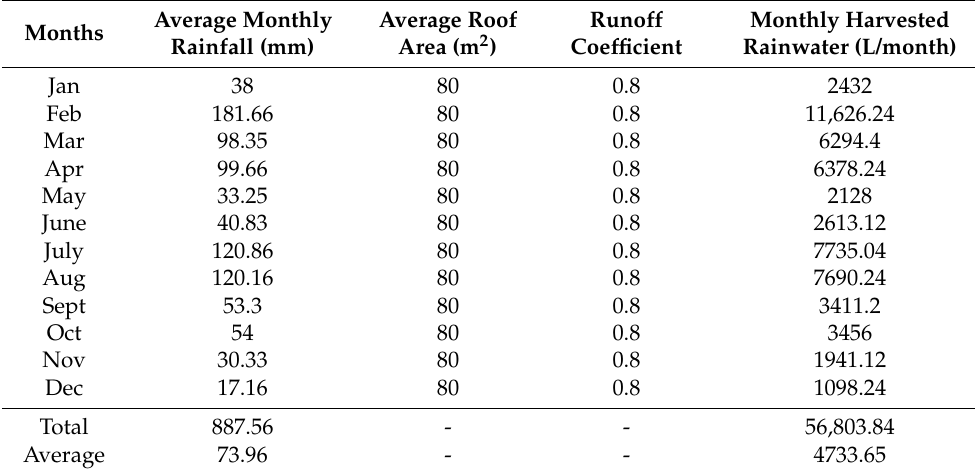
Table 5. Monthly harvested rainwater potential of the study